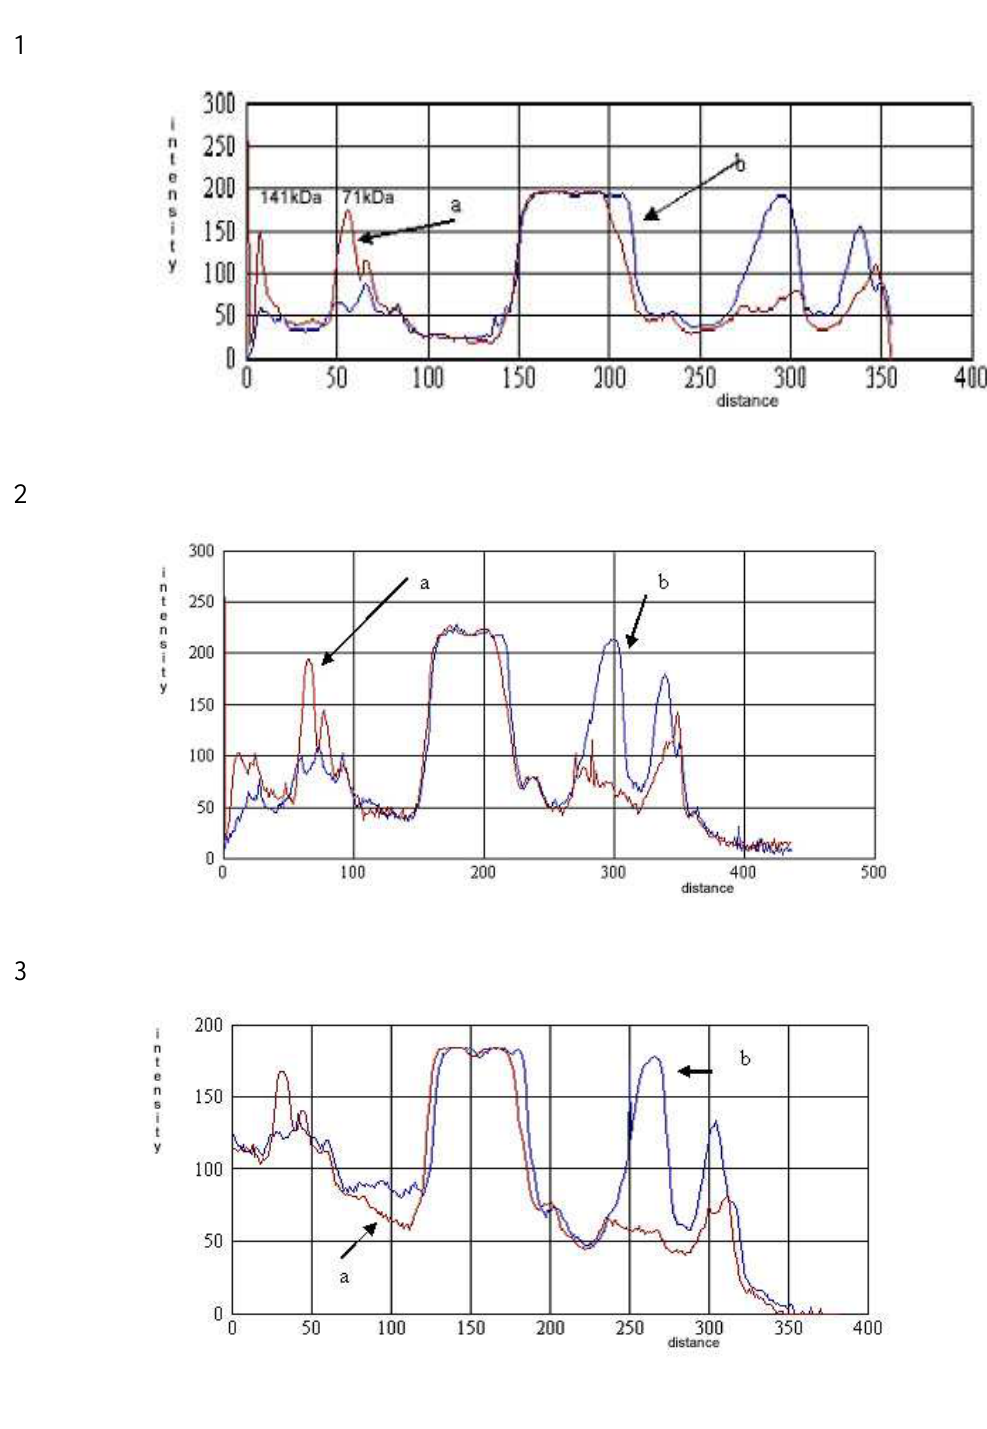
Figure 4 . The comparative densitometric analysis of the soluble reconstituted skim milk proteins treated at (1) 75°C and (2) 85°C for 20 min, and at 90°C for 20 min; with (a) and without (b) 2-